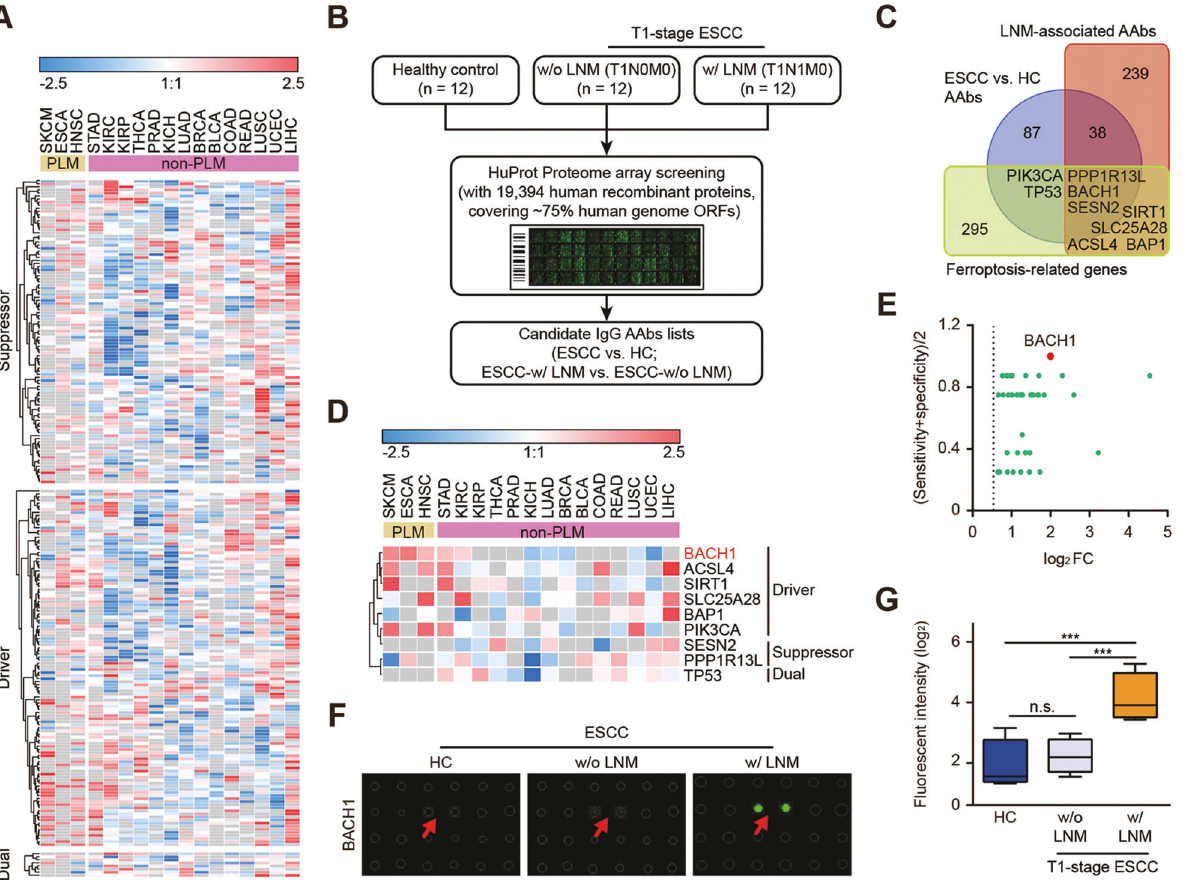
Fig. 1 Expression patterns of ferroptosis-related genes in tumors with preferential lymphatic metastasis or nonlymphatic/hematogenous metastasis. A Expression patterns of ferroptosis-related genes in tumors with preferential lymphatic metastasis or nonlymphatic/ hematogenous metastasis. The red color indicates overexpression in respective tumors, and the sky-blue color indicates downregulation in respective tumors, whereas grey indicates no difference between tumor and nontumor tissues (FDR-adjusted Wilcox test). The blocks beneath the TCGA RNA sequencing datasets indicate the classi fi cations of metastatic types. Some key ferroptosis regulatory genes are labeled; among them, BACH1 was overexpressed in tumors with preferential lymphatic metastasis (PLM). SKCM, skin cutaneous melanoma (metastatic lesions vs. primary tumors); ESCA, esophageal carcinoma; HNSC, head and neck cancer; STAD, stomach adenocarcinoma; KIRC, kidney renal clear cell carcinoma; KIRP, kidney renal papillary cell carcinoma; THCA, thyroid carcinoma; PRAD, prostate adenocarcinoma; KICH, kidney chromophobe; LUAD, lung adenocarcinoma; BRCA, breast invasive carcinoma; BLCA, bladder urothelial carcinoma; COAD, colon adenocarcinoma; READ, rectum adenocarcinoma; LUSC, lung squamous cell carcinoma; UCEC, uterine corpus endometrial carcinoma; LIHC, liver hepatocellular carcinoma; PLM, tumors with preferential lymphatic metastasis; non-PLM, tumors with preferential nonlymphatic metastasis. B Whole- proteome screening for serum autoantibodies (AAbs) associated with the tumor and lymph node metastasis (LNM) in esophageal squamous cell carcinoma (ESCC). We employed a discovery strategy to identify serum AAb candidate biomarkers for early-stage ESCC using a proteome array-based approach. The screened serum samples were collected from healthy controls (HC), T1-stage ESCC patients without lymph node metastasis (w/o LNM, T1N0M0) and T1-stage ESCC patients with lymph node metastasis (w/ LNM, T1N1M0). These sera were loaded onto a human proteome microarray of 19,394 recombinant proteins to acquire an AAb repertoire in response to ESCC and LNM. ORF, open reading frame. C Overlapping genes among the three groups (ESCC vs. HC AAbs, LNM-associated AAbs and ferroptosis-related genes). BACH1 was the only shared gene among the three groups. D Heatmap of overlapping genes in in tumors with preferential lymphatic metastasis or nonlymphatic/hematogenous metastasis. E The discriminatory ability (sensitivity + speci fi city) and fold changes of the upregulated AAbs on the HuProt arrays in the IgG channel. Each dot represents an AAb. Anti-BACH1 AAbs completely distinguished patients with LNM from those without LNM. F Typical anti-BACH1 IgG AAb scanning image and fl uorescence intensity quanti fi cation of the microarray. G BACH1 showed a strong anti-human IgG signal in patients with ESCC w/ LNM but a weak signal in healthy controls (HC) and patients with ESCC w/o